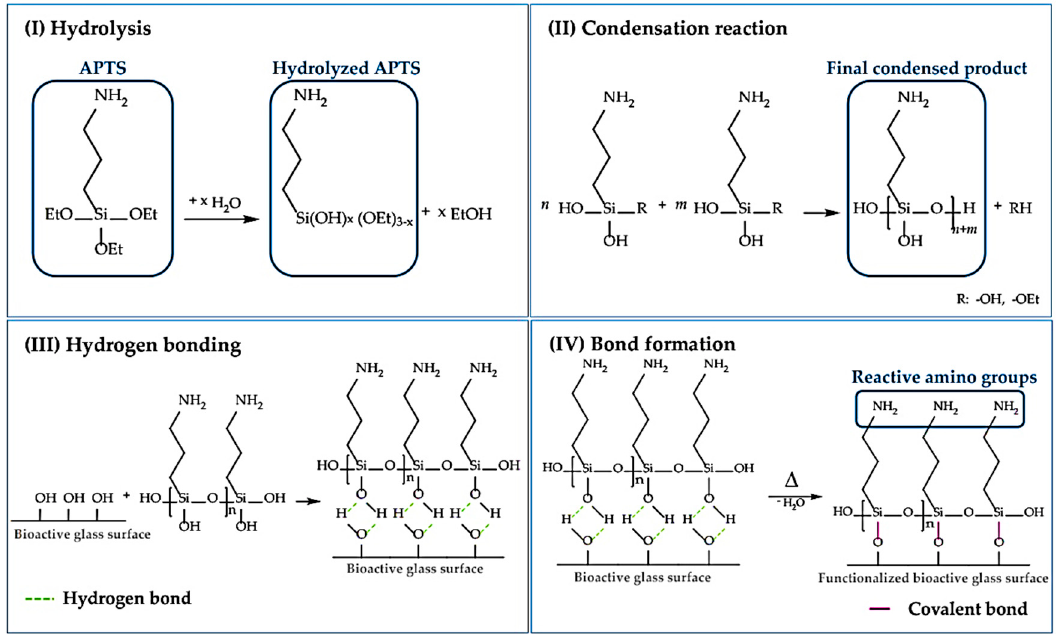
Figure 2. Schematic representation of different steps of surface functionalization of 45S5 glass-based scaffolds by using APTS. Adapted from Reference [43] .